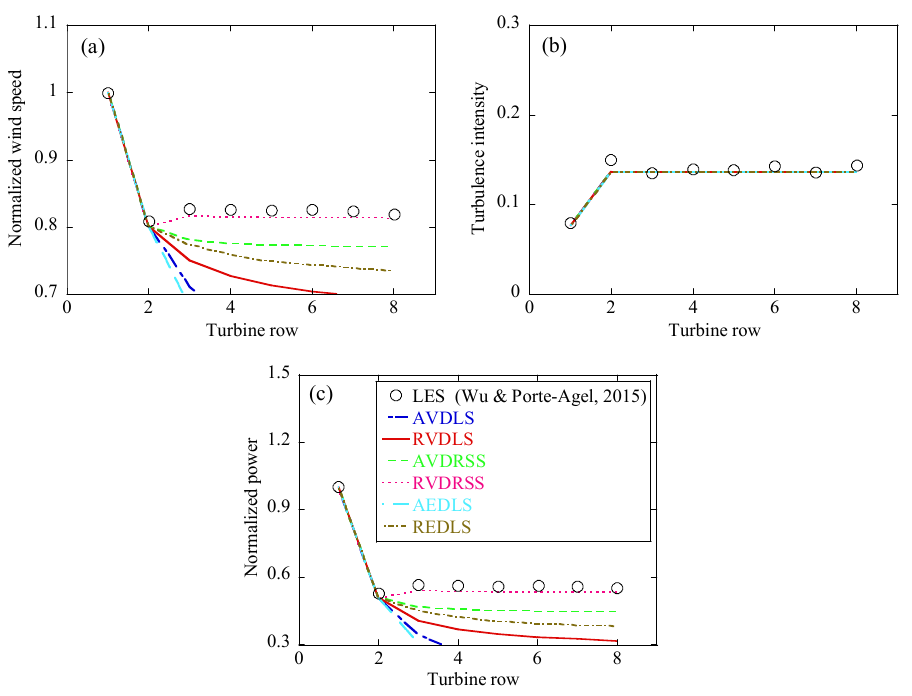
Figure 10. Comparisons of: ( a ) velocity deficit; ( b ) turbulence intensity; ( c ) power generations between simulations and predictions by the No. 37 combined wake model with different superposition approaches. In addition, it is interesting to note that turbine ‐ induced velocity deficit and wind power generation for multiple turbines in a row can be accurately predicted by the top ‐ hat type wake models, including the No. 46, No. 47, No. 52, and No. 53 combined wake models while the turbulence intensities are underestimated as illustrated in Figure 11. The top ‐ hat type wake models cannot accurately evaluate the velocity deficit for a single wind turbine since spanwise distributions are different from measured wake data and they maintain the same value over the whole rotor area. However, they neglect the process to calculate the equivalent velocity as shown in Equation (9) which may induce some errors.